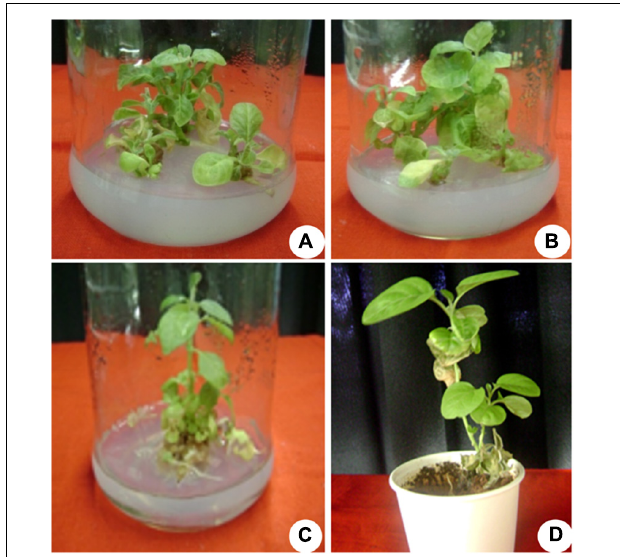
FIGURE 1 | The in vitro culture of Withania somnifera . (A) Shoot multiplication (scale = 2.5 cm), (B) shoot elongation (scale = 3.6 cm), (C) shoot elongation and rooting (scale = 5.8 cm), and (D) hardening of plantlets (scale = 7.7 cm).